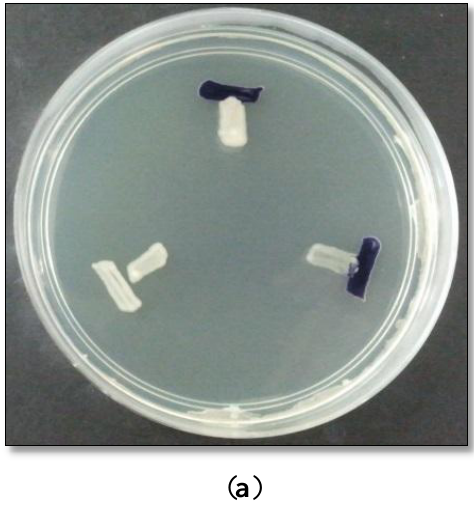
Figure 1. ( a ) AHL screening of strain M004 with CV026. E. carotovora PNP22 and E. carotovora GS101 served as negative and positive controls respectively. ( b ) AHL screening of strain M004 with E. coli [pSB401]. E. carotovora PNP22 and E. carotovora GS101 served as negative and positive controls, respectively.